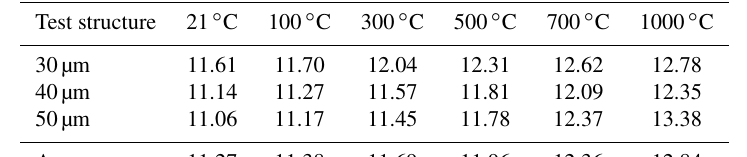
Table 5. Calculated permittivity ε r at 2MHz of sapphire up to 1000 ◦ C for different thin film interdigital structures, with 30, 40, and 50µm width and spacing.